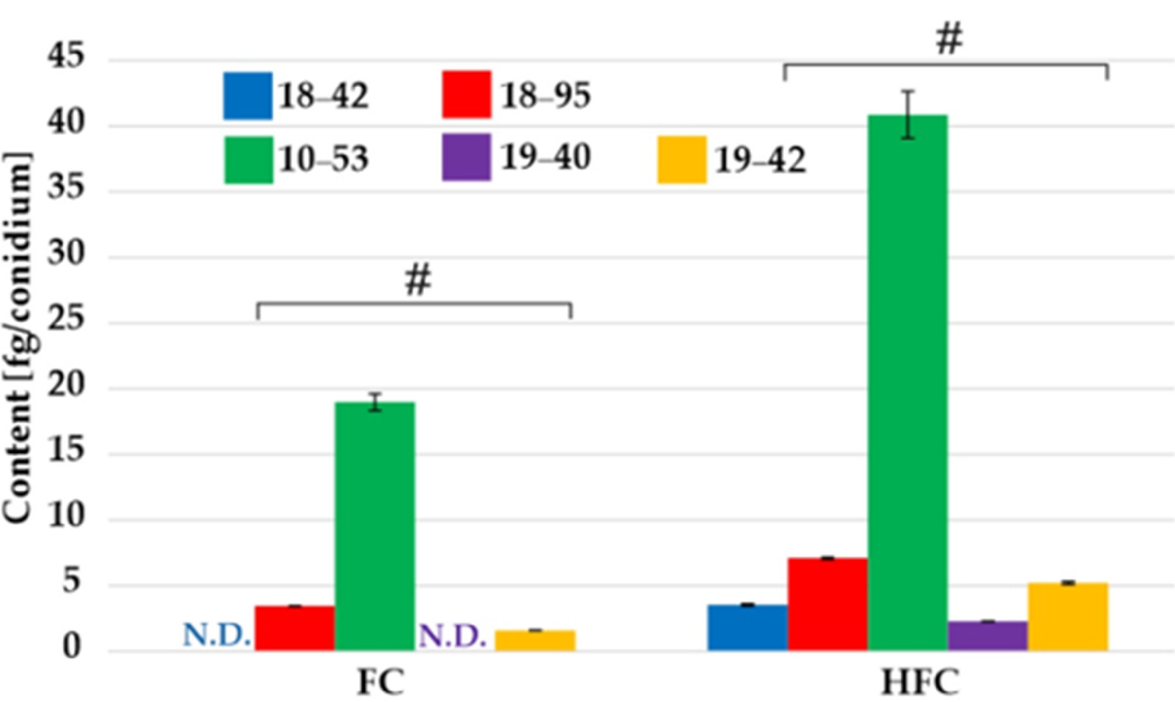
Figure 3. The HFC/FC content variation in A. fumigatus conidia. No significant differences or trends were observed between the VF and the VI strains, indicated by an # symbol. N.D. denotes the FC content below limit of detection, i.e., 0.3 fg/conidium. See also Supplementary Materials Table